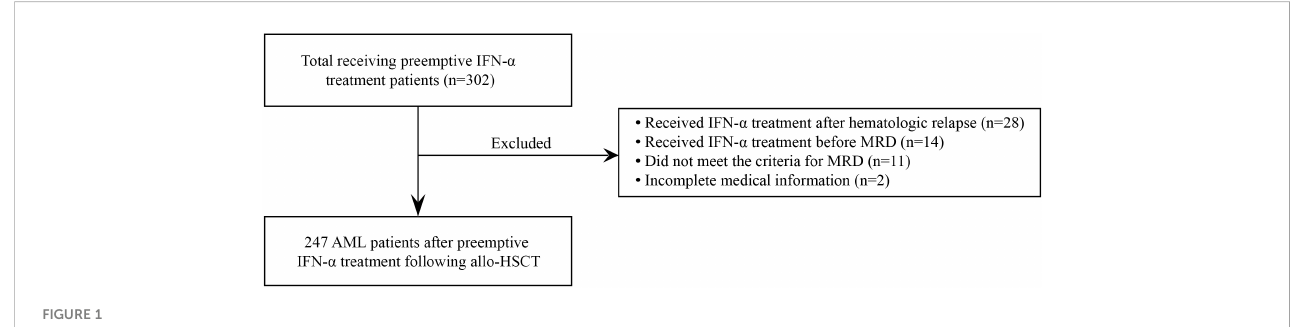
FIGURE 1 Diagram of enrolled patients.